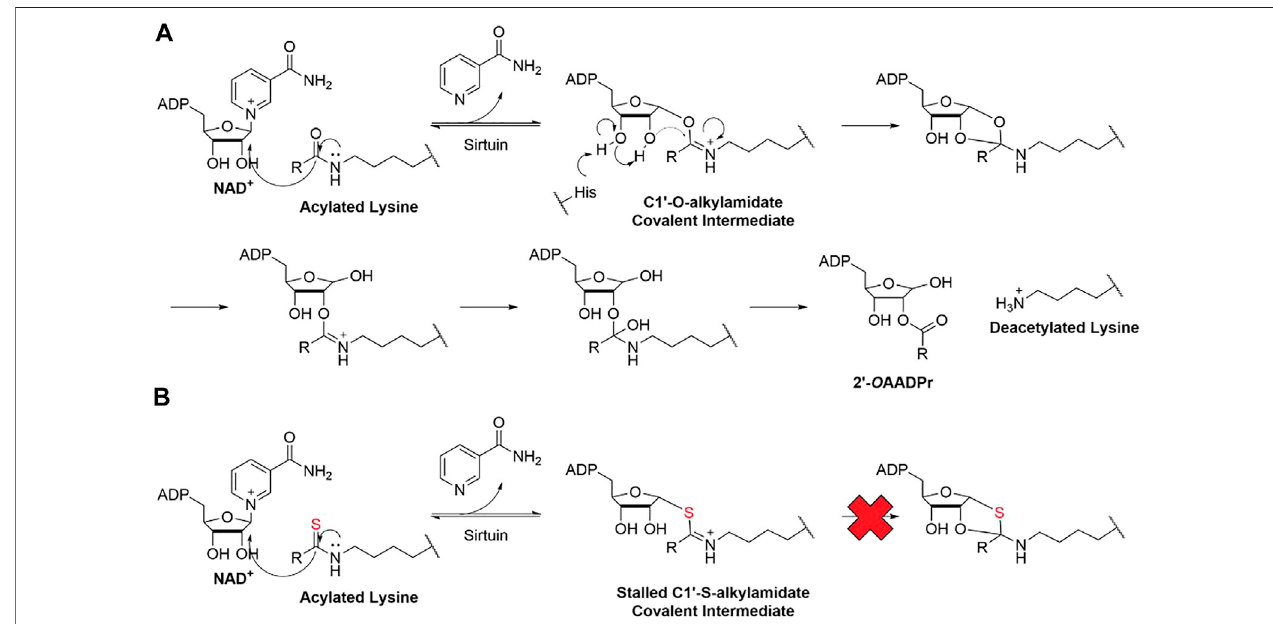
FIGURE 1 | (A) Schematic summary of sirtuin deacylation mechanism. (B) Schematic summary of mechanism-based inhibition of sirtuin